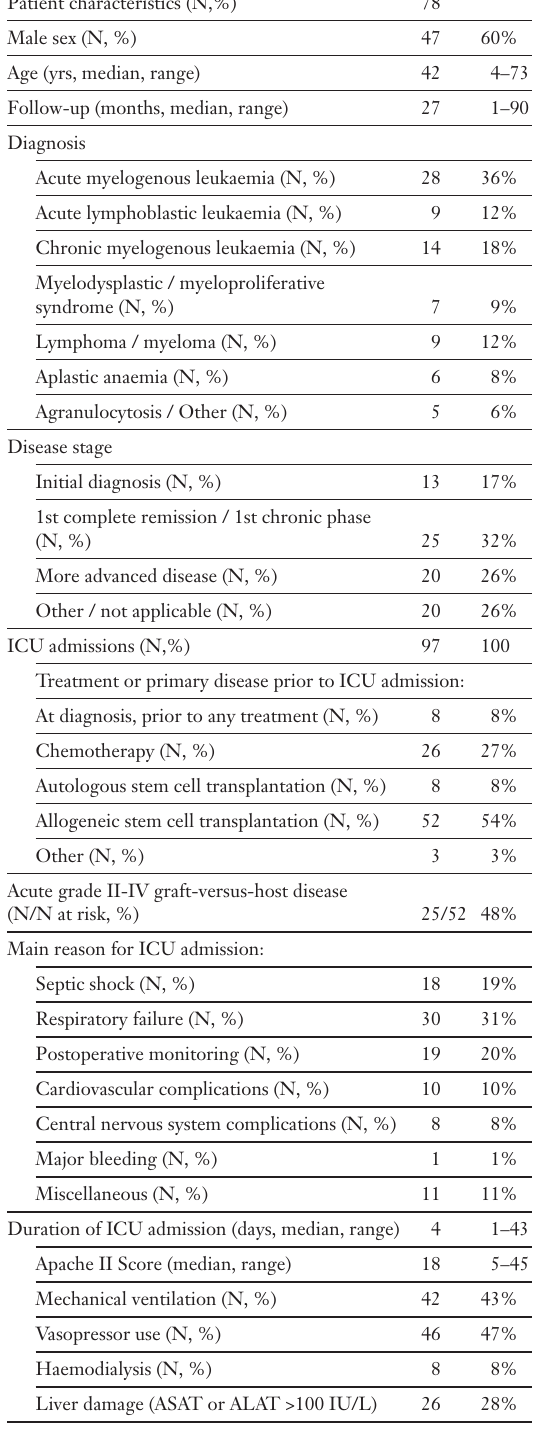
Patient and admis- sion